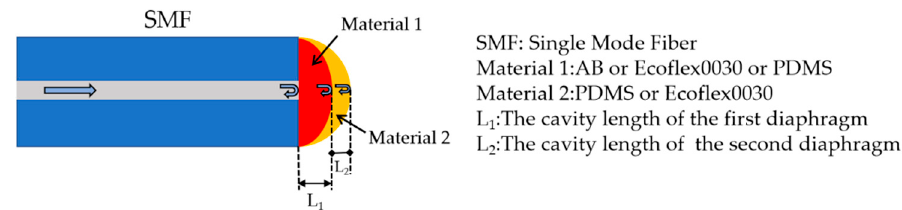
Figure 1. The composite structure based on dual FP cavities.